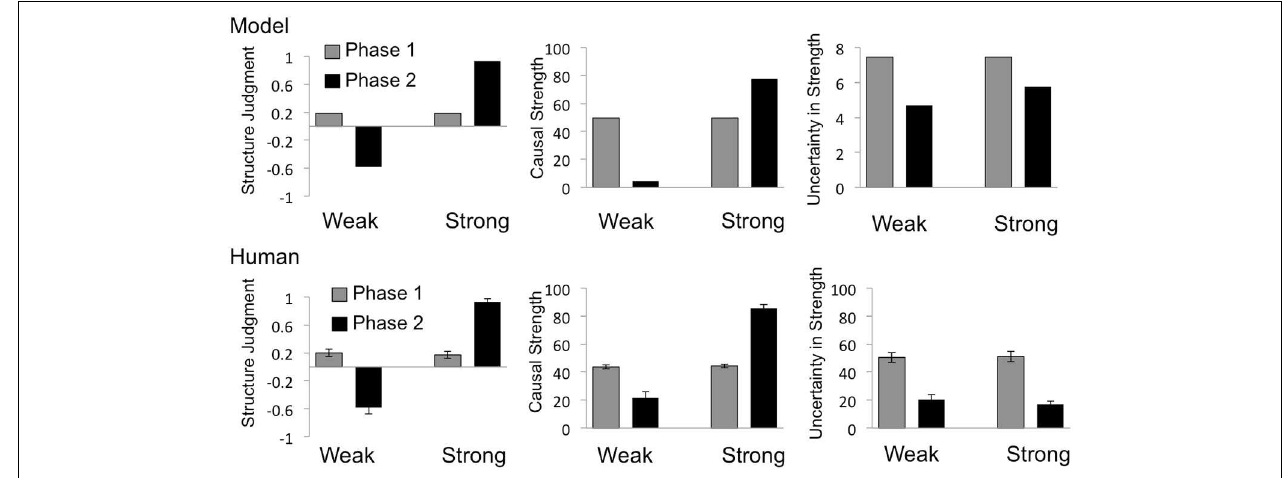
FIGURE 3 | Model predictions and behavioral results for the confounded target cause. Predictions of the Bayesian causal model are shown in the top row, and mean human judgments in the bottom row, for structure judgments (left), strength estimates (middle) and uncertainty in strength estimates (right). Structure